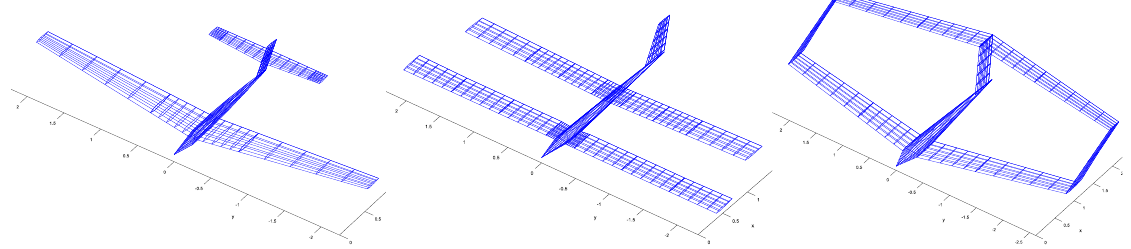
Figure 6. Examples of wing-tail ( left ), tandem-wing ( centre ) and box-wing ( right ) aircraft architec- tures generated in SD2020.